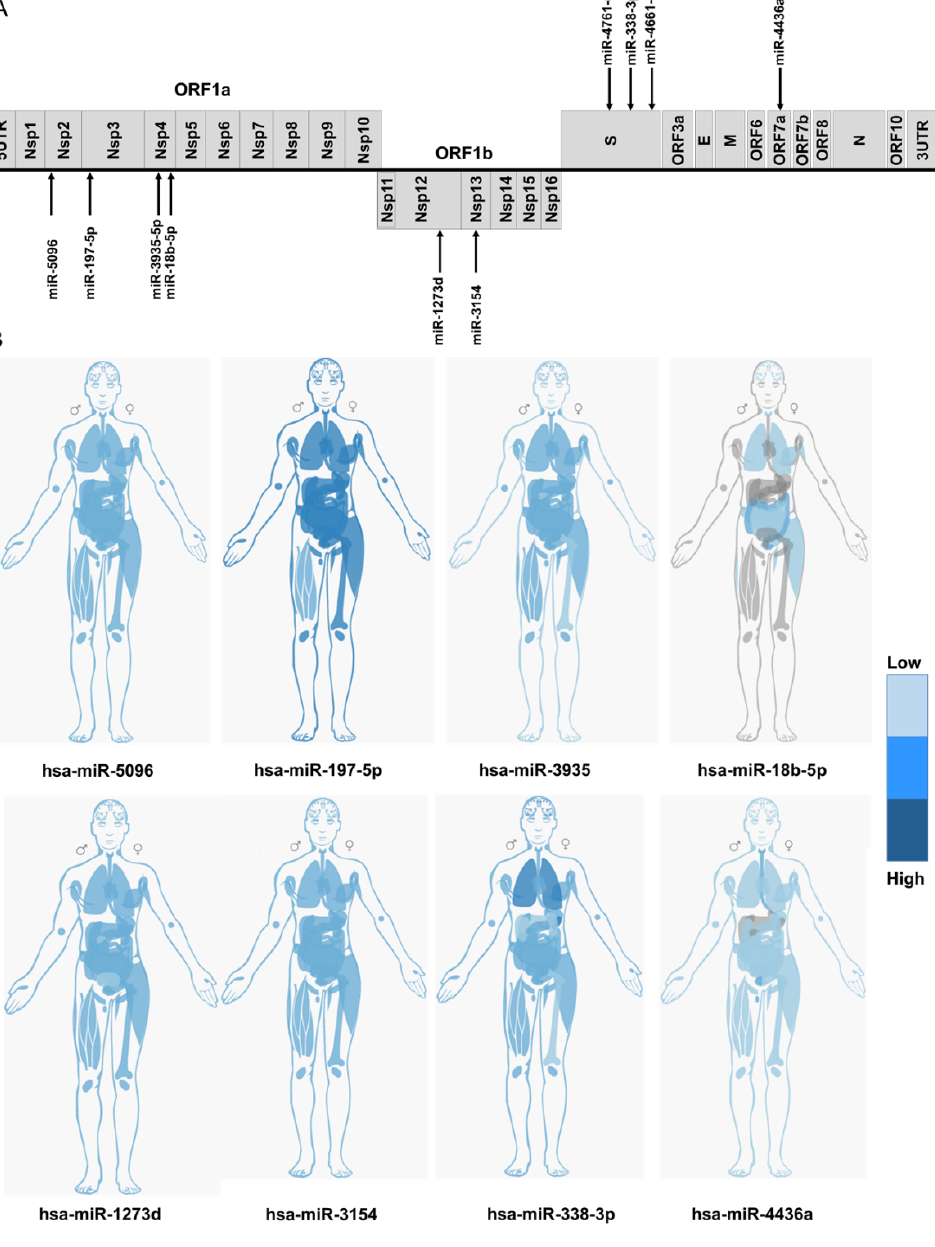
Figure 4. ( A ) Identification of host miRNA targeting different regions of SARS-CoV-2 genome. ( B ) The relative expression level of candidate miRNA in different human tissues. Data was obtained from the IMOTA database. Darker blue indicates the higher expression. Grey colour shows undetectable expression in those tissues. The plotted presentations of miRNA expression in different human tissues obtained from TissueAtlas and TISSUES databases are available in the supplementary figure file.